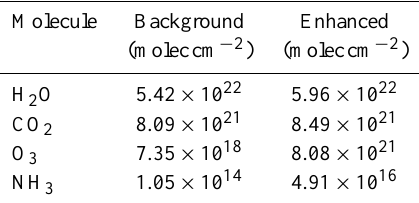
Table 1. Column amounts used in the CrIS simulated forward model calculations in Fig.